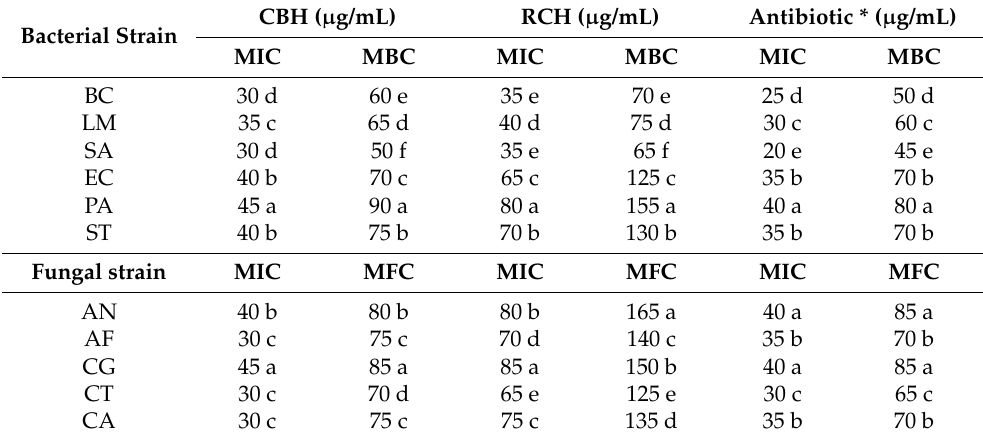
Table 4. The lowest concentration ( µ g/mL) of CBH, RCH, and antibiotic, inhibiting microbial strains, (MIC), and the lowest concentration ( µ g/mL) killing bacterial strains, (MBC), and fungal strains,